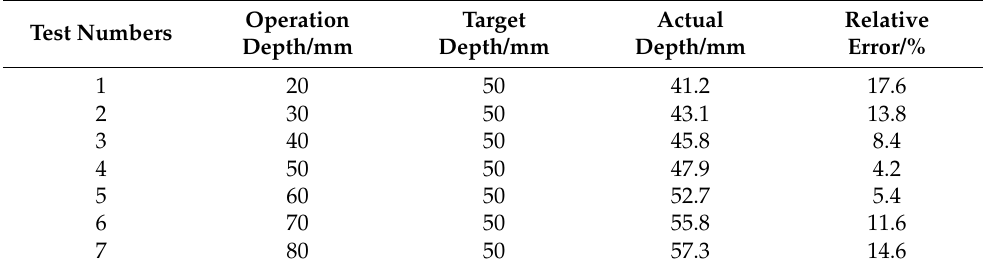
Table 5. Profiling performance test results of self-adaptive control